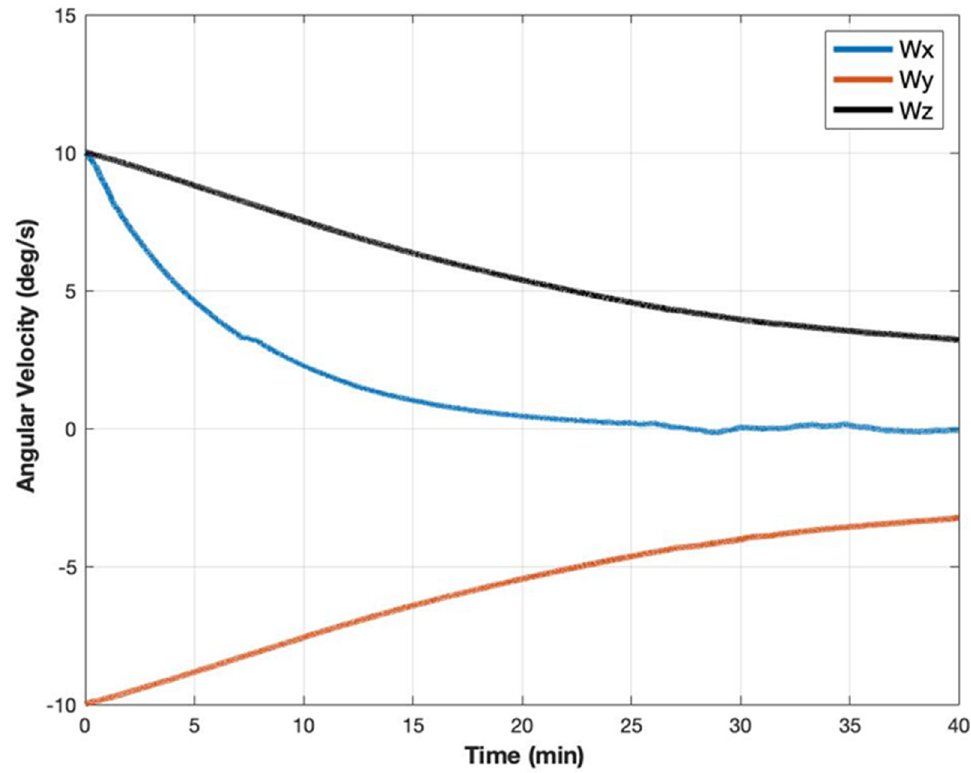
not included in the simulations to ensure that the reaction wheels are able to maneuver and do not saturate. The environmental disturbances were assumed to be constant and represent the highest possible environmental disturbances. Table 9 shows the input values used to run the simulation, while Figures 10 and 11 show the quaternion response and angular momentum response for the reaction wheels respectively for Aalborg and Vilnius.